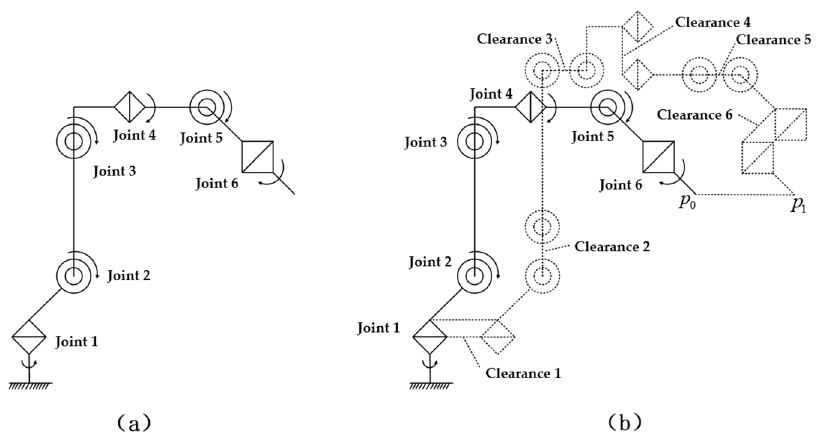
Figure 6. Diagram of the joint clearance of the robot mechanism.